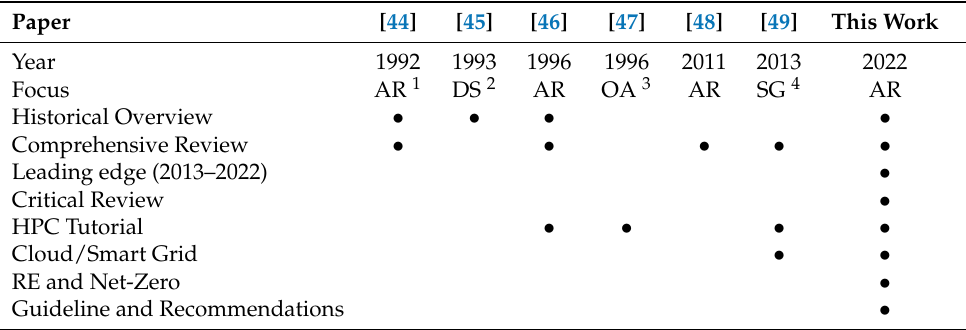
Table 1. Previous work and related reviews.